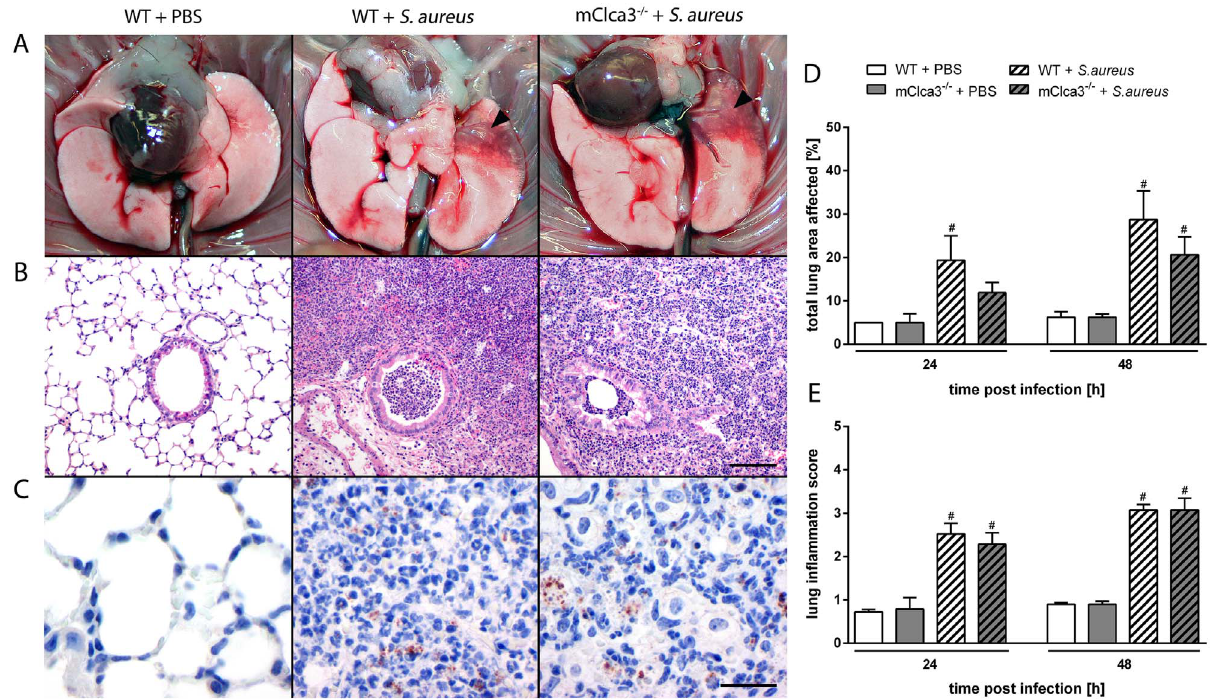
deeply red consolidated areas in the infected lungs (arrowhead) in contrast to PBS controls which behaved virtually identical. (B) Subsequently, lungs were fixed, embedded in paraffin and stained with hematoxylin and eosin for histopathological analyses. (C) Evidence of bacteria was assessed by immunohistochemistry with anti- Staphylococcus aureus antibody. Uninfected animals (left panel) served as negative controls. Brown , 3,3 9 - diaminobenzidine; blue , hematoxylin counterstain. (D) The total lung area affected by inflammation and (E) a lung inflammation score were determined. Values are given as mean 6 SEM (n=4 each group). # p , 0.05 versus the PBS control group. Bar (B), 100 m m. Bar (C), 20 m m.